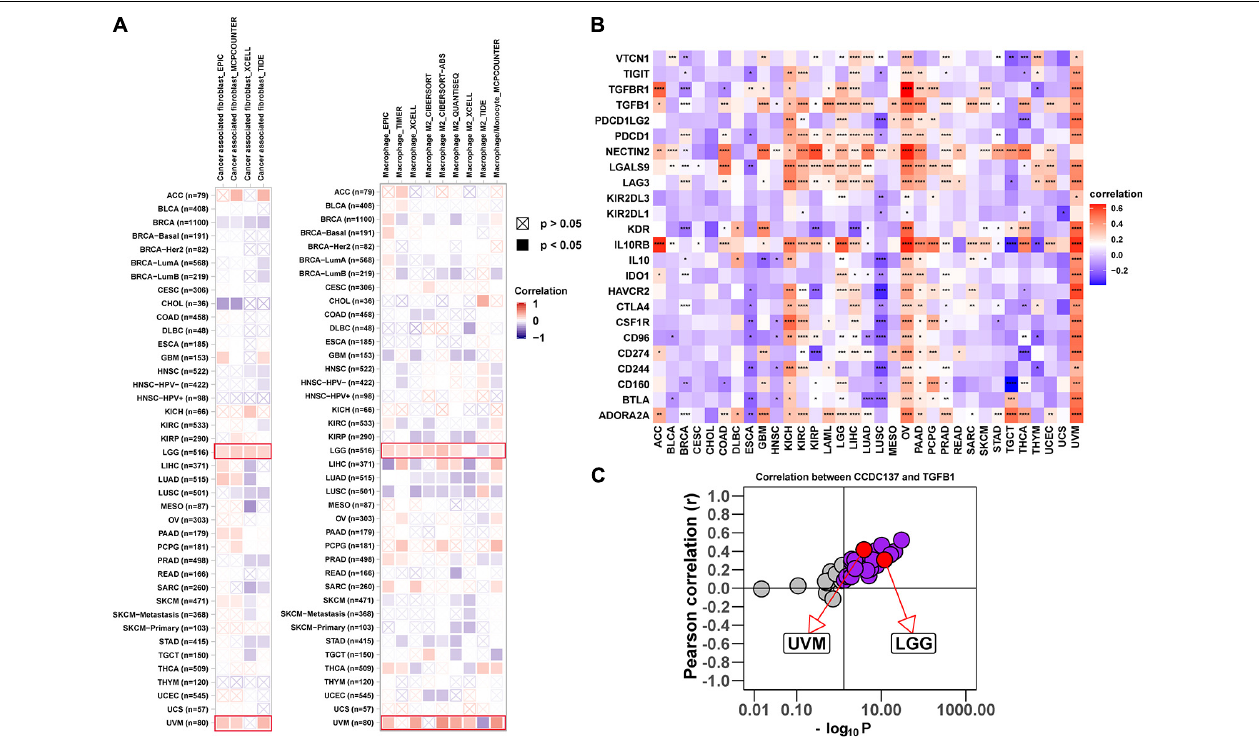
FIGURE 6 | Analysis of the effect of CCDC137 on immune microenvironment. (A) The correlation between CCDC137 expression and CAFs (left) or TAMs (right) were shown. Red color represents positive correlation, blue color represents negative correlation, and the deeper the color, the stronger the correlation. (B) The heatmap shows the correlation between CCDC137 and immunosuppressive genes in TCGA pan-cancer. (C) Correlation coefficient and –log10 ( p value) of CCDC137 with TGFB1 is shown. Each circle represents a different tumor type from TCGA. Red circles are marked for UVM and LGG. Gray circles mean no